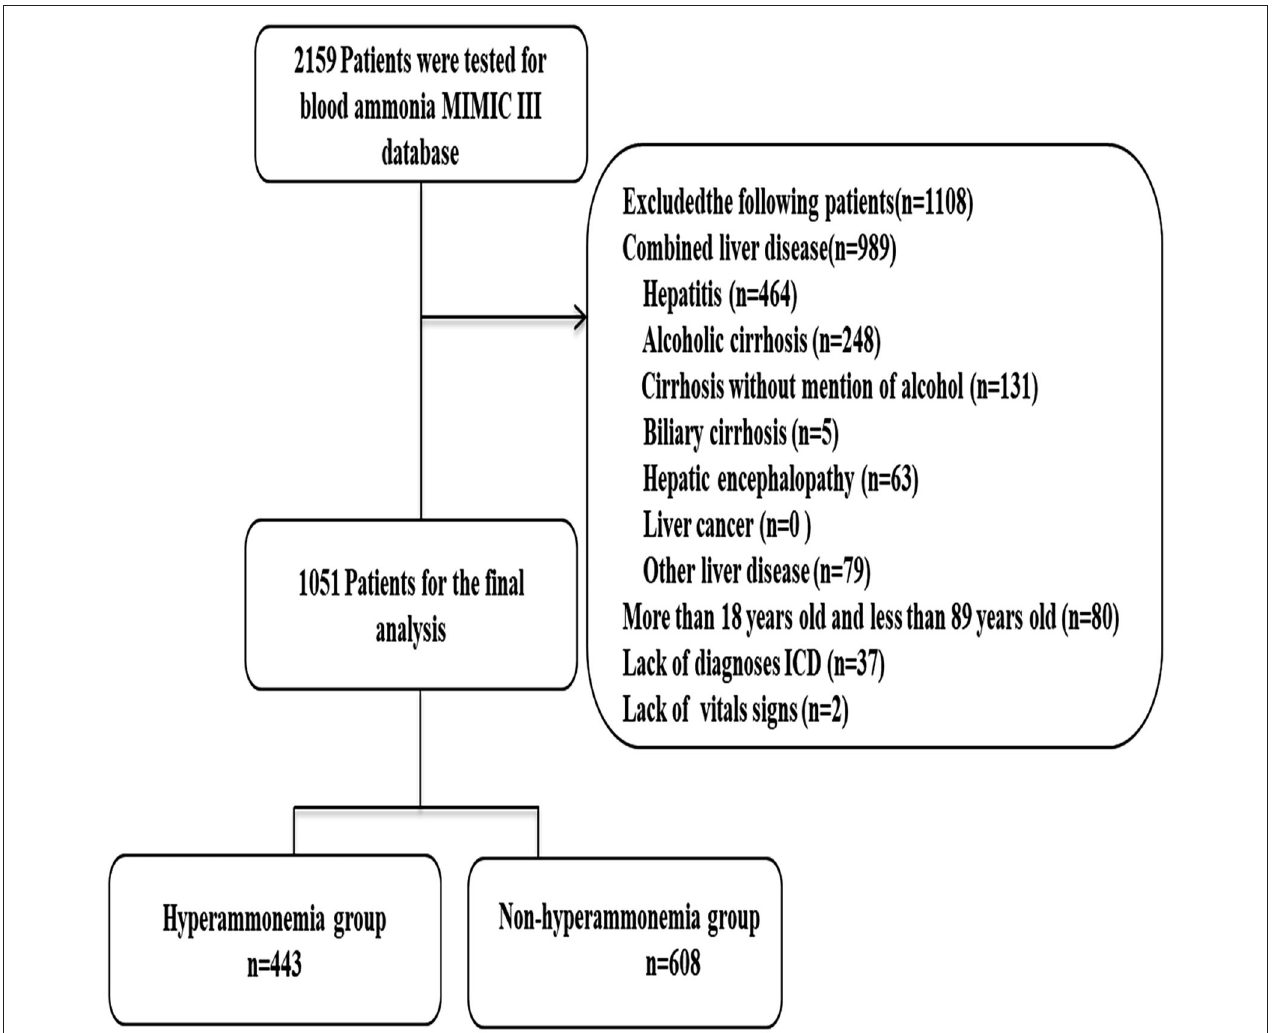
FIGURE 1 | Flow chart of patient selection. MIMIC-III, Medical Information Mart for Intensive Care